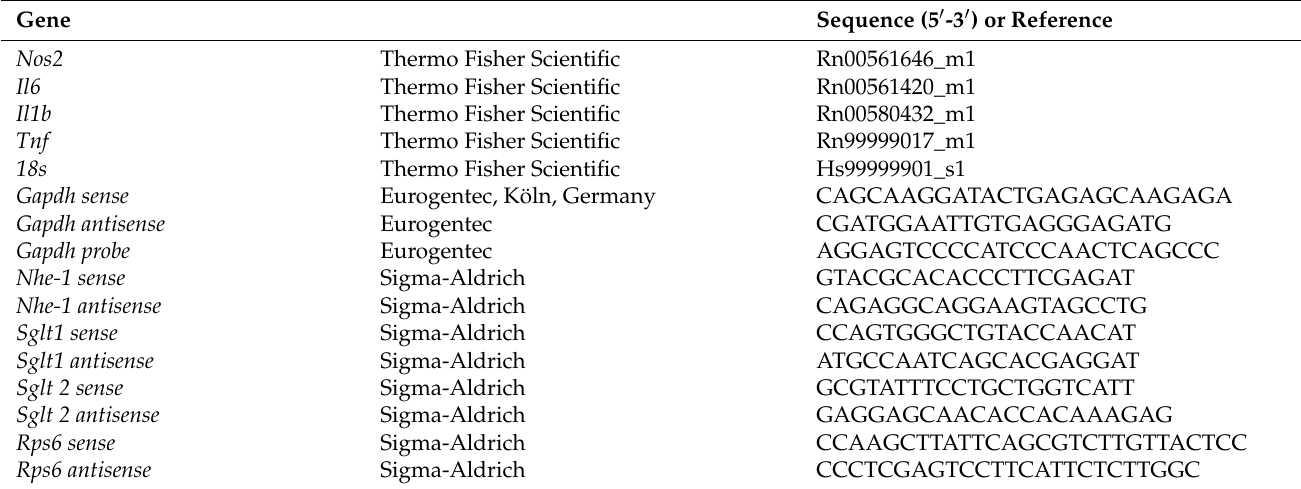
Table 1. Primers/probes